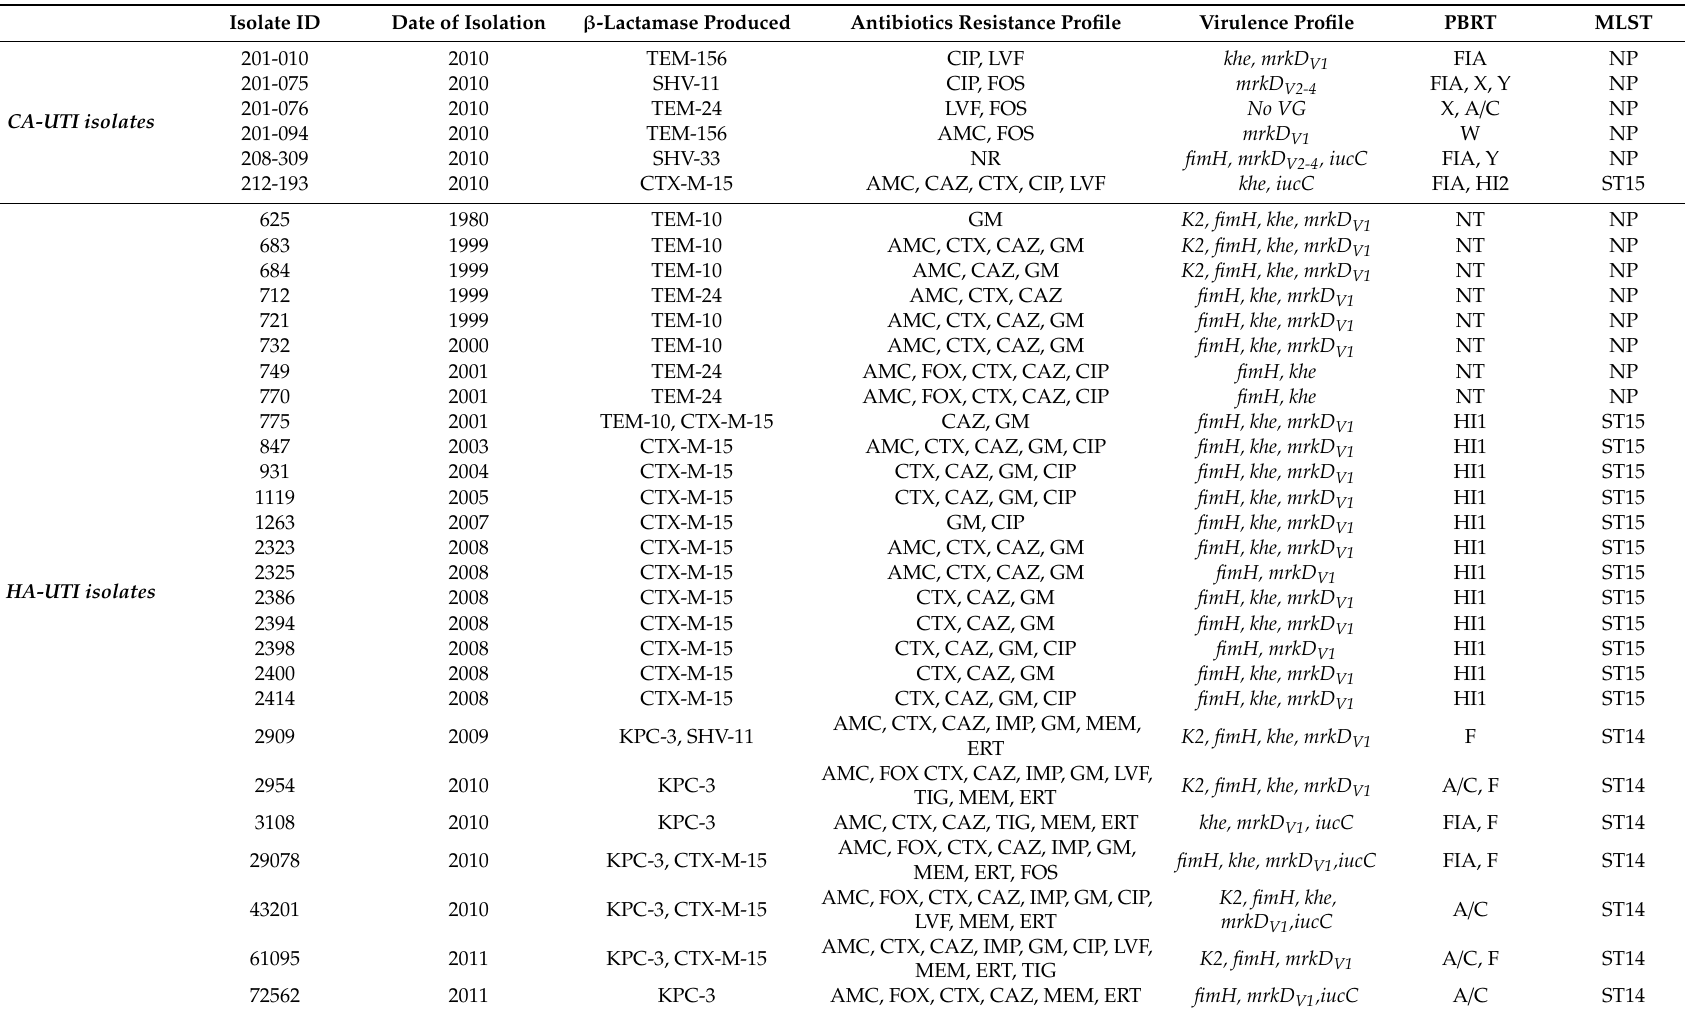
Table 1. Antibiotic resistance profile, distribution of virulence genes, and plasmid content of β -lactamases-producing K. pneumoniae community-acquired UTI isolates. Isolate